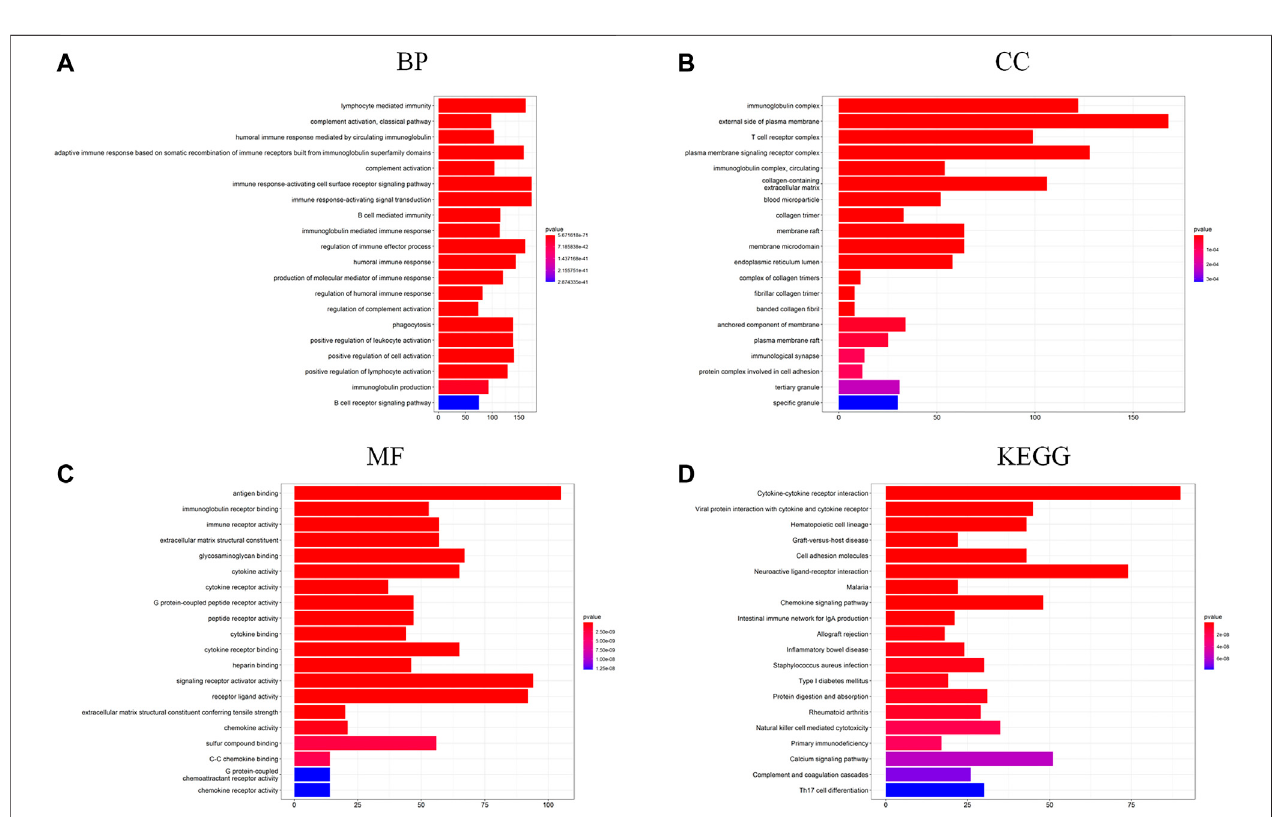
Frontiers in Genetics |